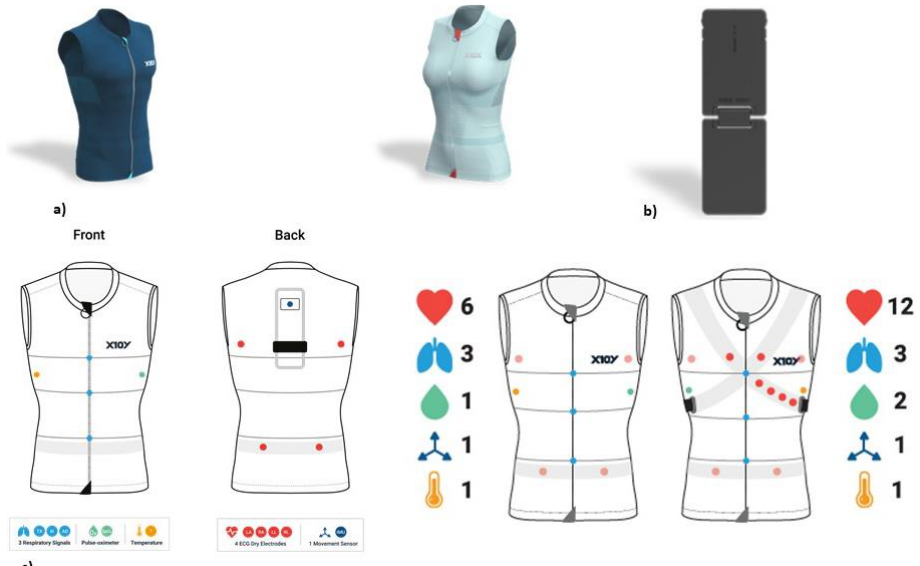
Figure 2. ( a ) Healer R2 wearable devices (male and female models); ( b ) Logger KoR 1, connecting to the back of the garment for storing the data and transferring them via 4G/5G/Wi-Fi; ( c ) embedded sensors to detect heart rate, respiratory rate, temperature, saturation, and desaturation. - Cardiovascular activity (mean, maximum, and minimum heart rates), thanks to a 6- lead ECG signal at 500 Hz using 4 ink-based dry electrodes;